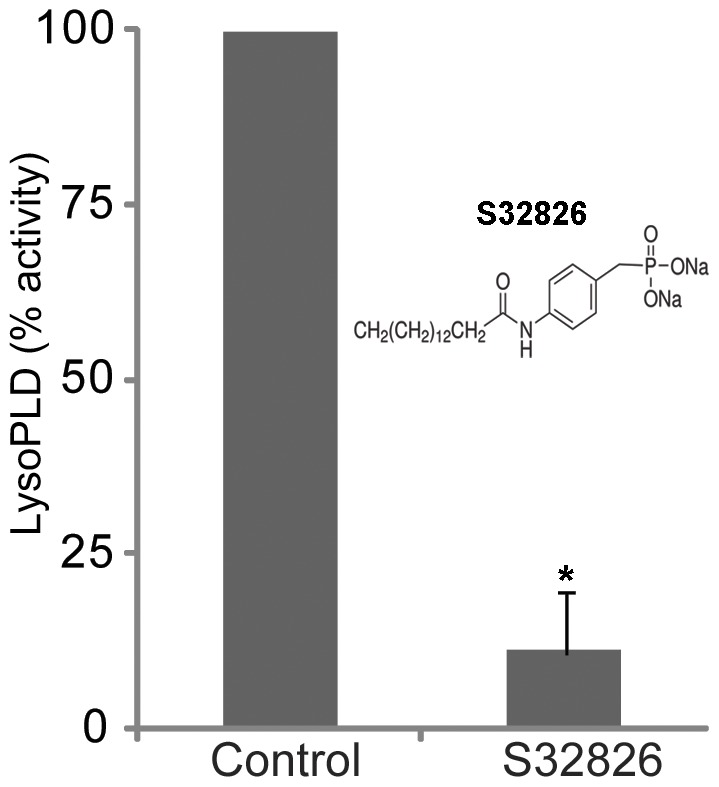

In vitro inhibition of rabbit AH LysoPLD activity by S32826.To confirm that S32826 inhibits LysoPLD activity of AH, 10 µg of AH protein derived from rabbits was pre-treated with S32826 in vitro for 20 minutes prior to analysis of LysoPLD activity using Amplex Red reagent and fluorimetric detection as described in methods. Rabbit AH LysoPLD activity was inhibited by more than 90% by 10 µM S32826 based on 4 independent observations. The chemical structure of S32826 is shown in the figure inset [29].